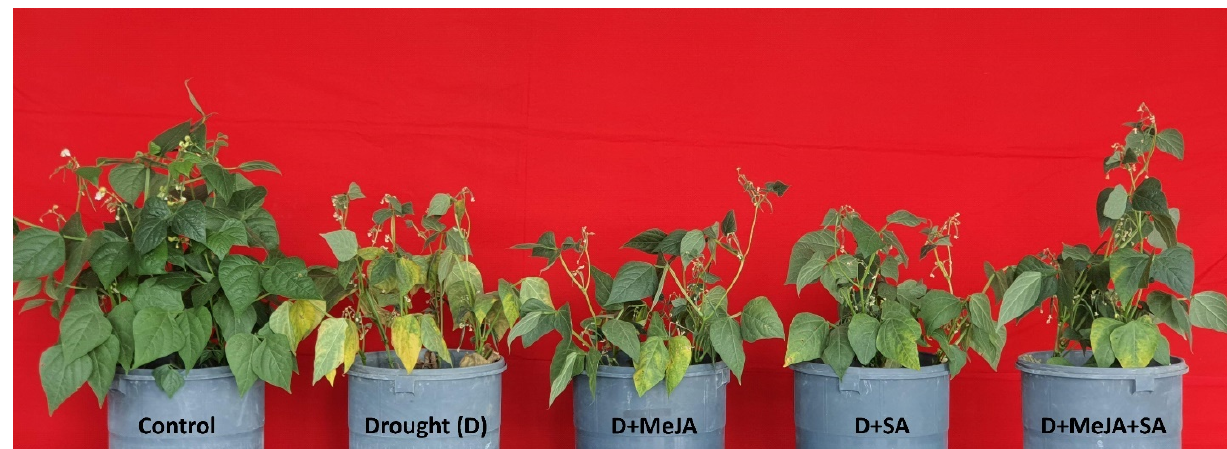
Figure 1. Phenotypic appearance of French bean plants: control, drought (D), and drought-stressed plants treated with methyl jasmonate (D + MeJA), salicylic acid (D + SA), and their combination (D + MeJA + SA) at the time of harvest. Control—plants grown under non-stress, well-irrigated conditions; drought—plants grown with a steady decline in moisture availability; D + MeJA—drought-stressed plants pre-treated (seed and foliar) with 20 μM methyl jasmonate; D + SA— drought-stressed plants pre-treated (seed and foliar) with 2 mM salicylic acid; D + MeJA + SA—drought-stressed plants pre-treated (seed and foliar) with a combination of 10 μM methyl jasmonate and 1 mM salicylic acid.